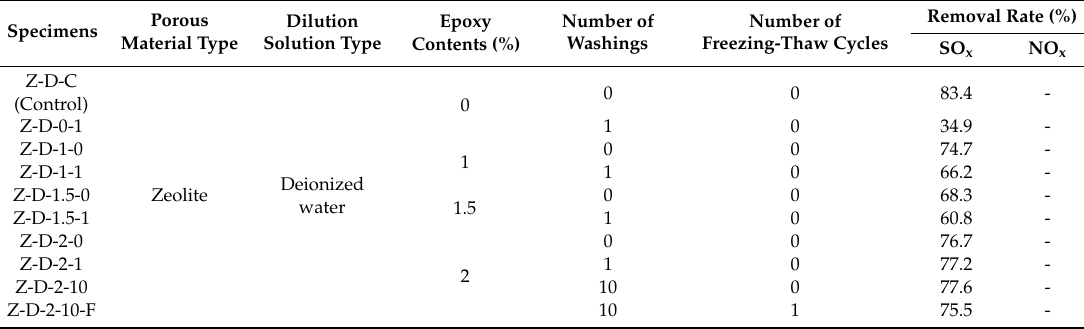
Table 5. Summary of the SO x and NO x removal rates of textile fabrics coated with zeolite or coconut shell activated carbon.